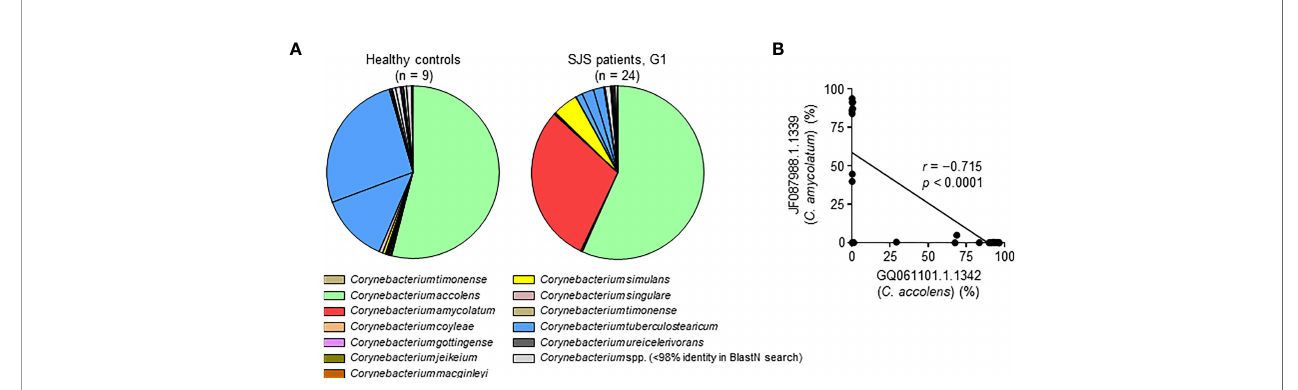
FIGURE 3 | Species-level characteristics of genus Corynebacterium 1 in healthy control subjects and SJS/TEN patients with SOC group-1 patients. (A) Results of a BlastN search of the 35 sequences of operational taxonomic units (OTUs) identi fi ed in genus Corynebacterium 1 . The pie graph shows the mean percentage of each OTU and is color-coded according to the 12 Corynebacterium species estimated from the OTU sequences as shown in Table S2 . (B) An exclusive relationship was found between the predominant Corynebacterium 1 species C. accolens (OTU GQ061101.1.1342) and C. amycolatum (OTU JF087988.1.1339) among SJS/TEN patients with SOC group-1 (G1). r , Spearman ’ s correlation coef fi cient; p , p -value; SJS, SJS/TEN patients with